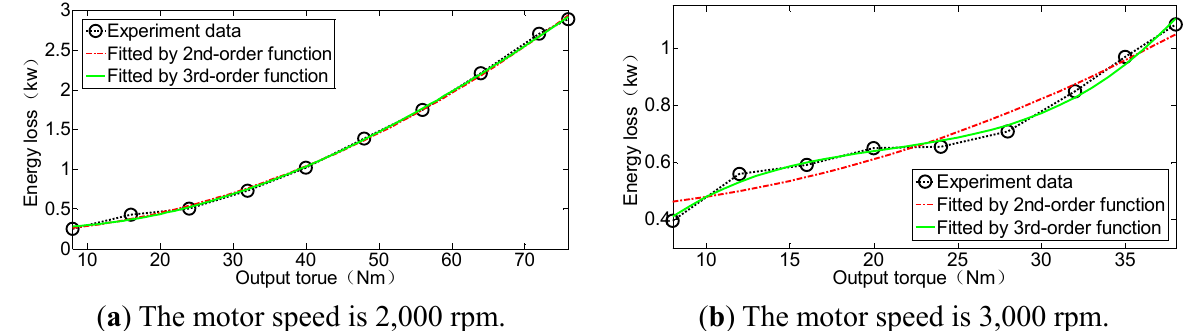
Figure 5. The fitting function of energy loss vs . output